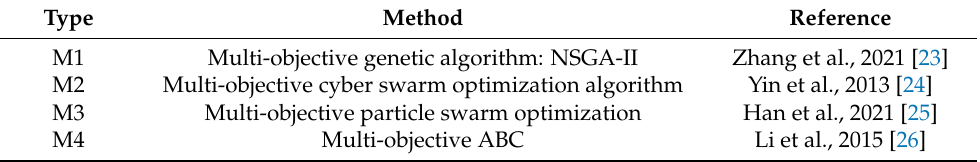
Table 1. List of competitors’ methods of comparing an NSP dataset for MBABC-NM.